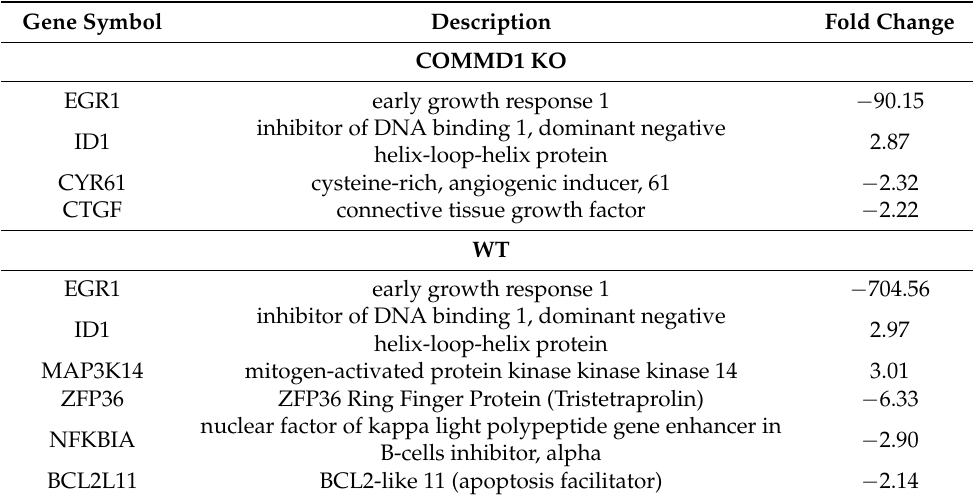
Table 3. Selected DEGs in untreated vs. CIGB-552-treated H460